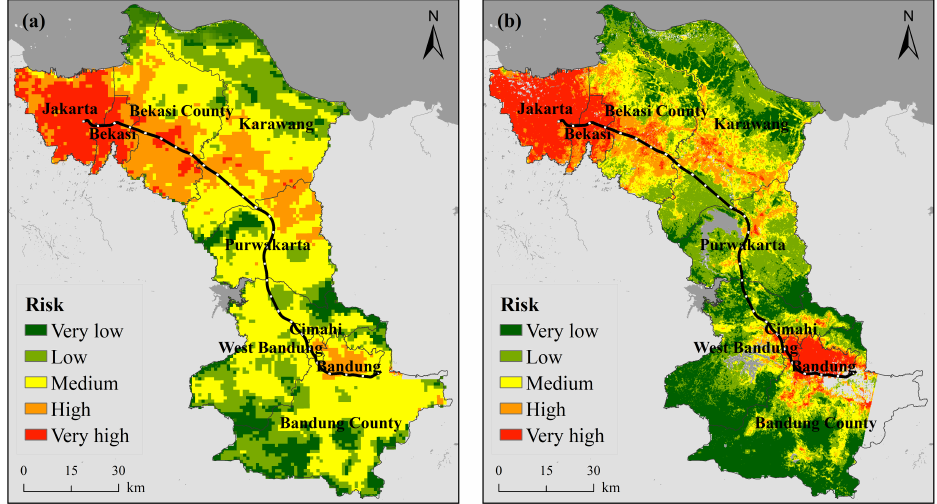
Figure 6. Heat wave risk distribution map (( a ) 2015 km scale, ( b ) 2014 hundred meter scale).